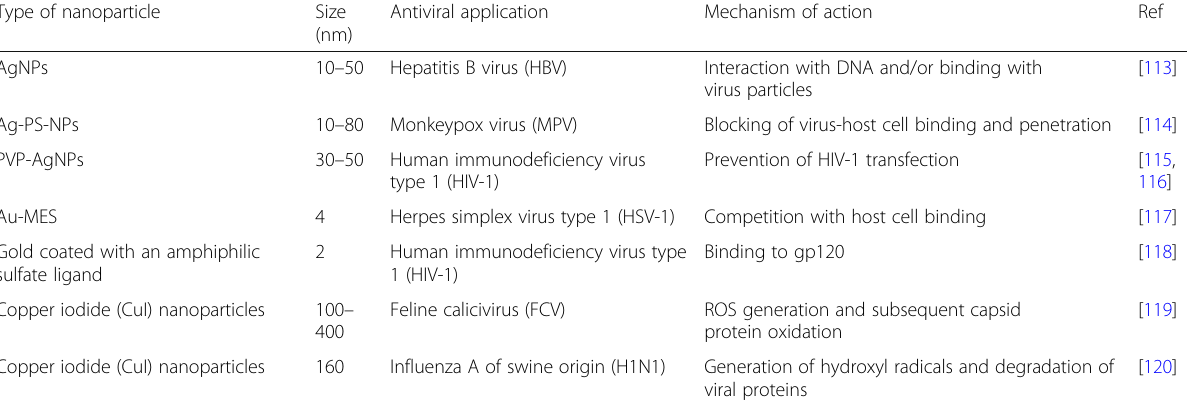
Table 2 Some of the metal nanoparticles and metal nanoparticle conjugates that have been demonstrated as having antiviral